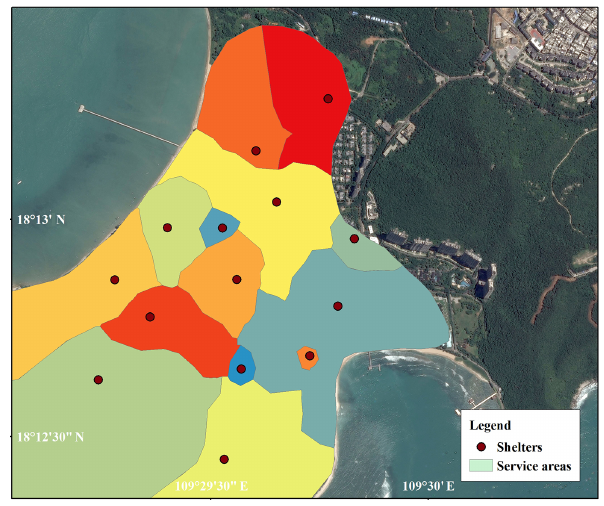
Figure 11. Study area for the dynamic evacuation